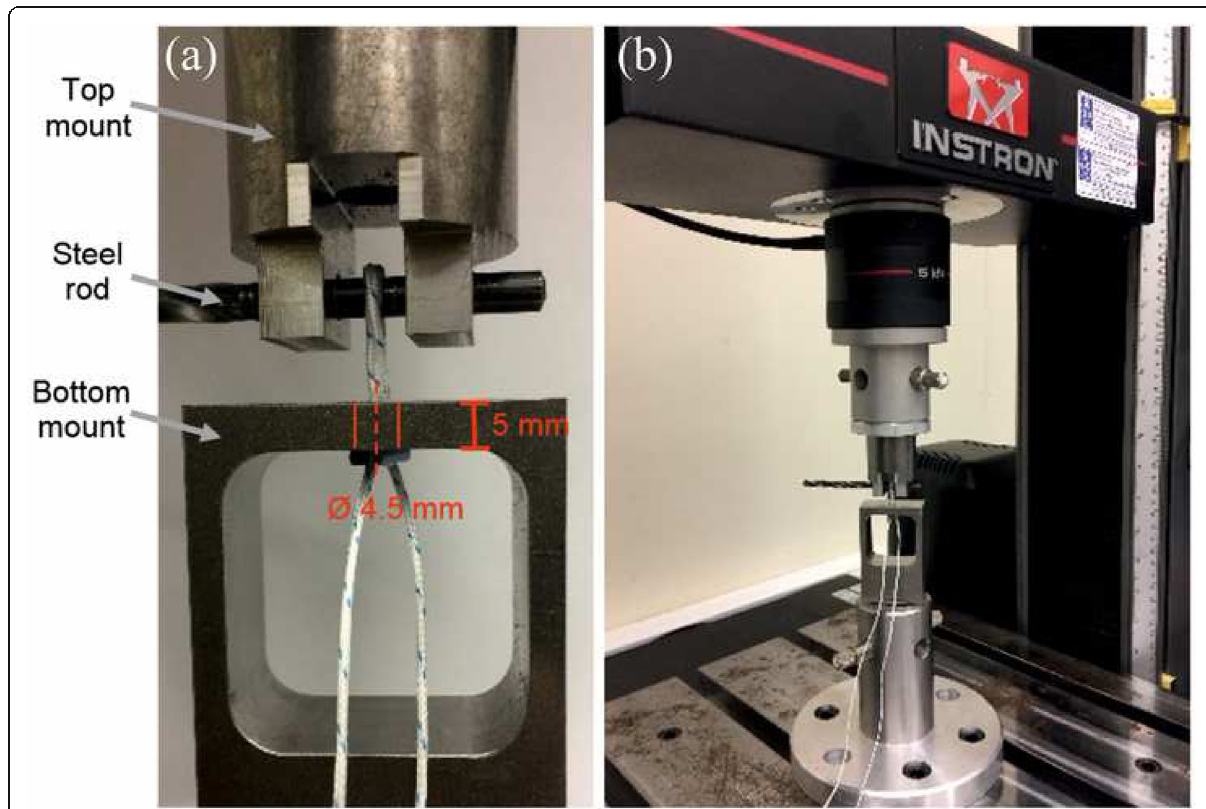
Fig. 3 Testing was performed on a simple, custom-built rig, fixed to an Instron machine (Instron, Illinois Tool Works Inc., Norwood, Massachusetts, USA). The rig comprised a bottom-mount attached to the baseplate, a top-mount attached to the crosshead and 5 kN load cell, and a 4.5 mm horizontal steel rod held between two holes in the